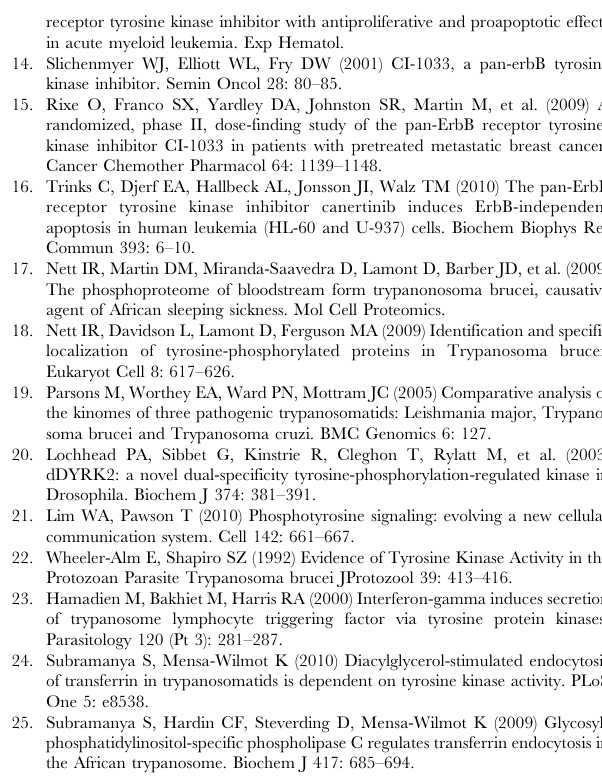
Table S1 Properties of Peptides Used to Identify Protein Protein Kinases. (DOCX) Table S2 Proteins eluted with lapatinib or AEE788 or canertinib (100 m M each) after 1 M KCl wash of ATP- affinity column. Only proteins for which two or more peptides were identified are listed. Proteins eluted with DMSO (1%) (solvent for the drugs) were identified in a separate analysis and eliminated from the drug-eluted proteins in the table. (XLS) Table S3 Proteins eluted with 10 m M lapatinib after 1 M KCl wash of ATP-affinity column. Proteins containing 2 or more peptides are listed.